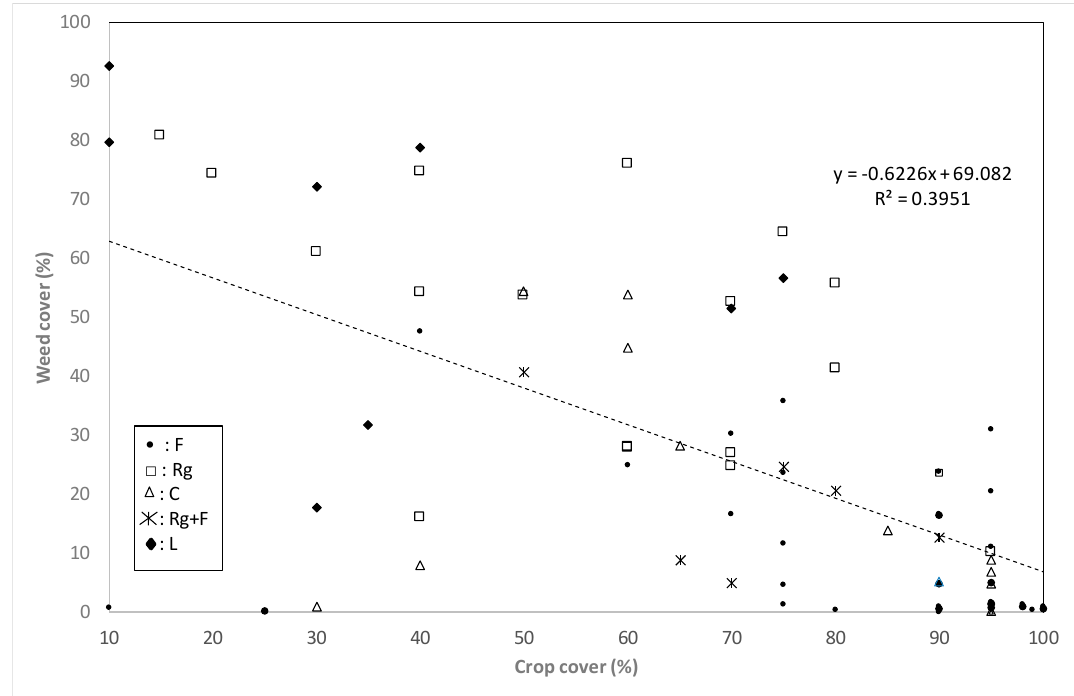
Figure 2. Regression between crop cover (%) and weed cover (%) in the surveyed plots of all crops and in all seasons pooled together.